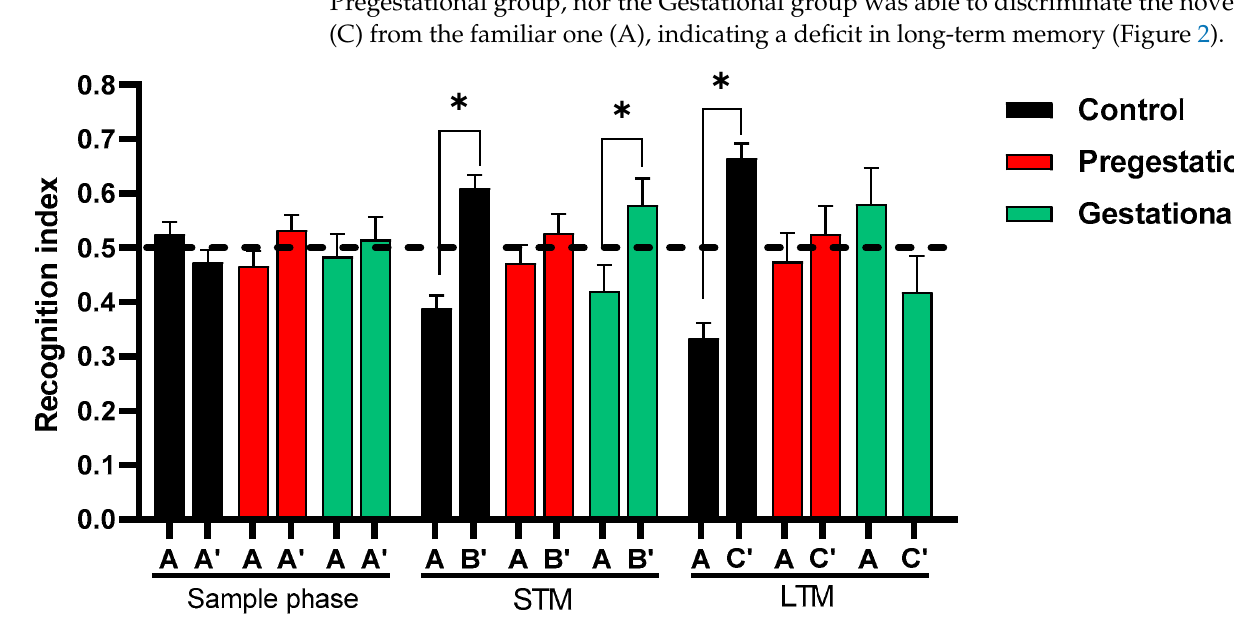
Figure 2. Evaluation of familiarization, short-term memory (STM) and long-term memory (LTM) phases in the progeny of rats exposed to T. gondii lysate before gestation (Pregestational) and on day 18 of gestation (Gestational) through NOR. The data represent mean ± S.E.M. recognition index (time exploring novel object/time exploring both objects × 100) of 12–15 animals per group. * p < 0.05 between the novel and familiar objects. Mann-Whitney U test.